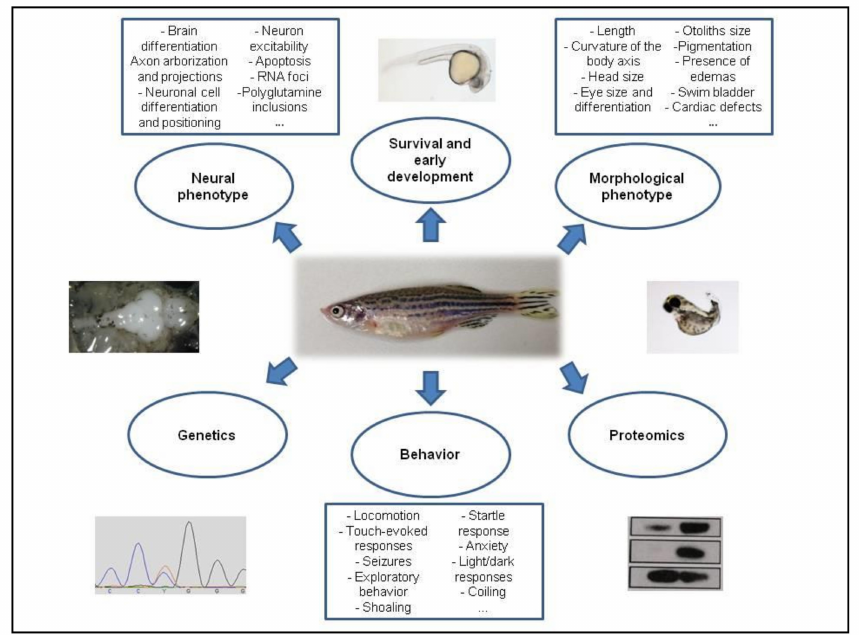
Figure 2. Summary of the main tests that can be applied to zebrafish models of neuronal diseases. Dorsal view of the brain to the left, female adult zebrafish in the center and a zebrafish embryo with morphological defects to the